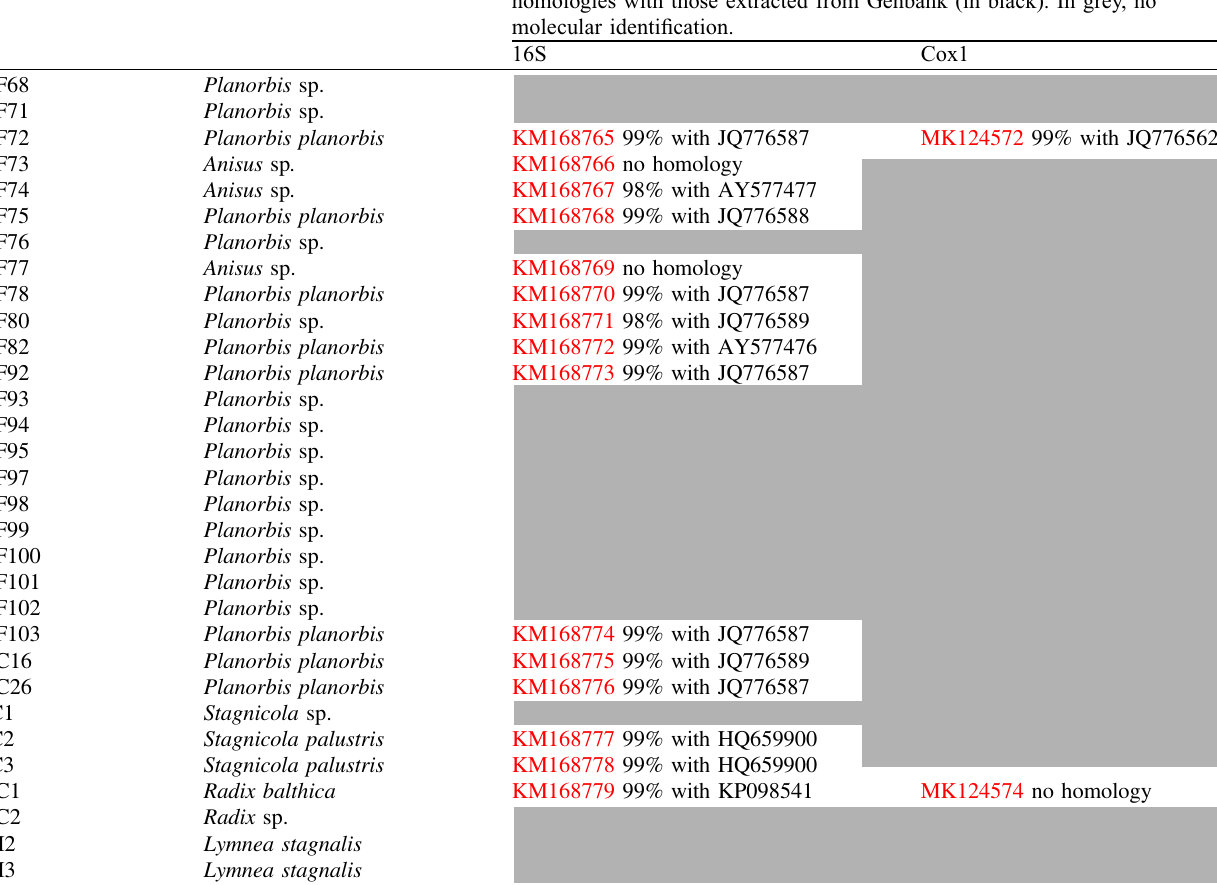
FO: ocellated pigmented furcocercariae, LF: furcocercariae with or not eyes spots, EC: cercariae of Echinostomidae, XI: Xiphidiocercariae, DR: Der-Chantecocq lake, DC: National Domain of Chambord, ZE: Zebulle Park Chevenon, JO: